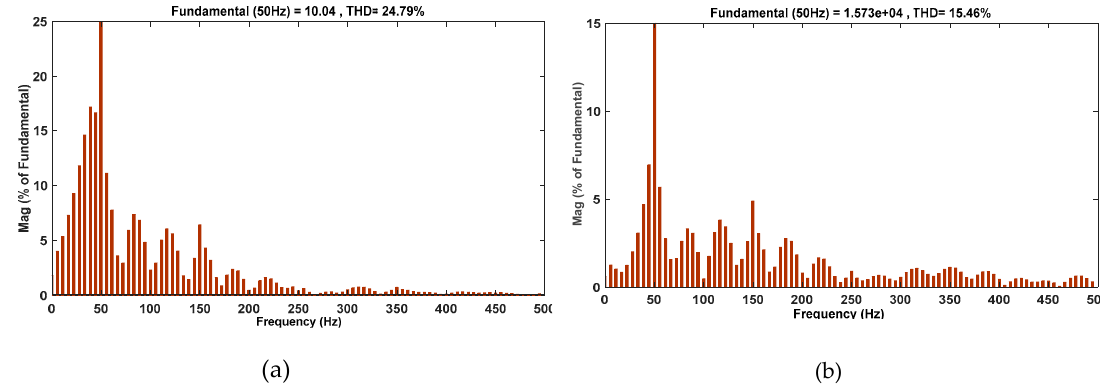
Figure 13. THD with PI + Crowbar scheme for grid current ( a ) and voltage ( b ) during the P-G fault.